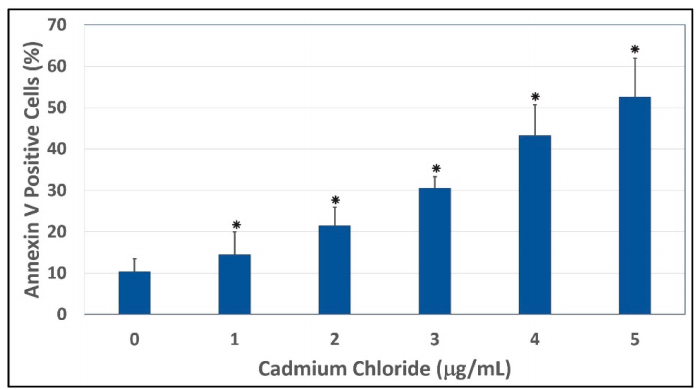
Figure 6. Annexin V and PI positive cells. Cells were exposed to different concentrations of cadmium chloride as described in the Materials and Methods. * Significantly different ( p < 0.05) from the control, according to the Dunnett’s